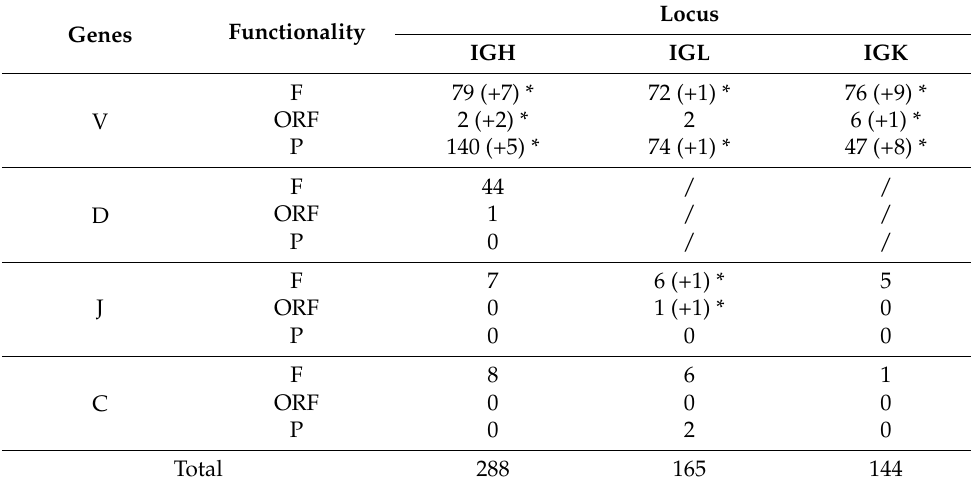
Table 2. Number of V, D, J, and C genes per functionality, in the IGH, IGK and IGL loci of Macaca mulatta